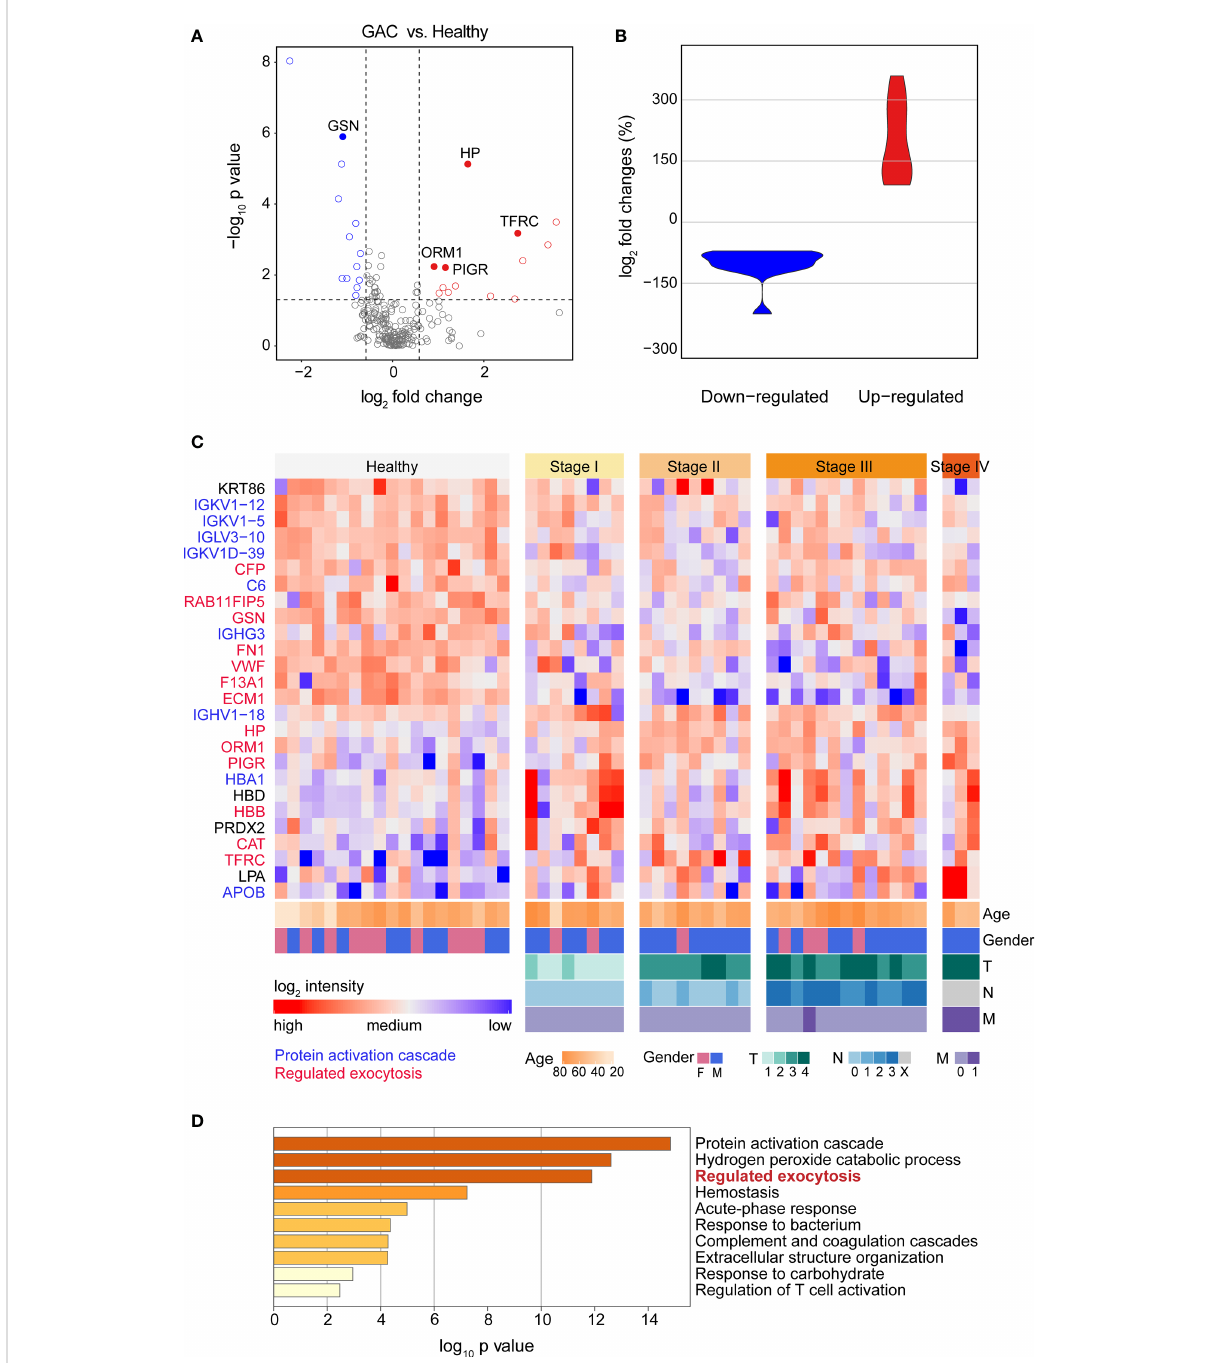
FIGURE 3 Proteomic pro fi les of serum EV proteins between heathy subjects and GAC patients. (A) Volcano plot of statistical signi fi cance value against log 2 -fold change between GAC patients (N=33) and heathy controls (N=19) from cohort 1, showing differentially expressed proteins in blue (down) or red (up) circles. (B) Violin plot showing fold changes of up- and down-regulated proteins. (C) Heat map of 26 differentially expressed proteins between GAC patients and healthy subjects. Intensities of proteins were log 2 -transformed. Different color in protein names indicates different biological processes derived from these proteins. (D) Gene Ontology (GO) analysis of differentially expressed proteins between GAC patients and healthy